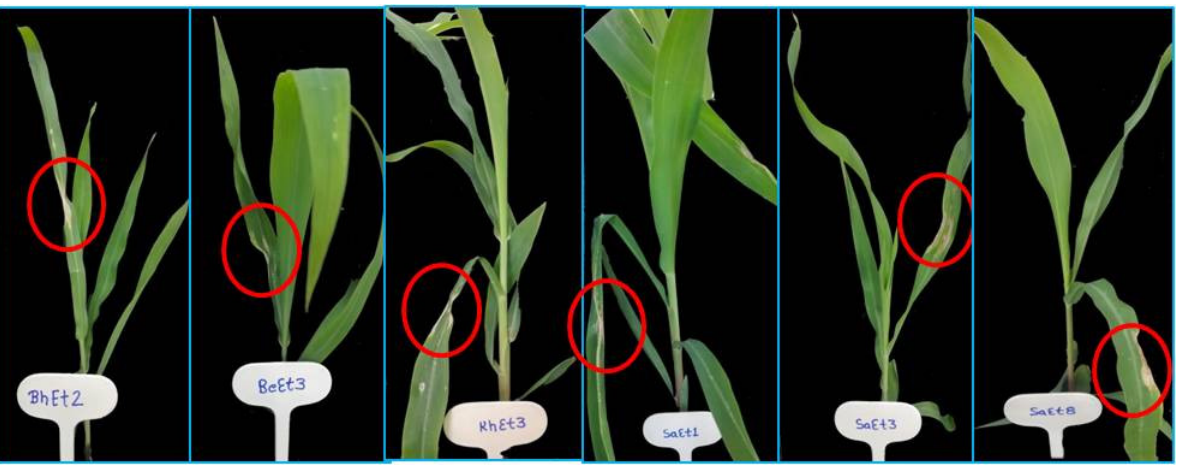
Figure 4. Disease reaction of E. turcicum race 123N on differential line ‘2′ after 14th days of inoculation.